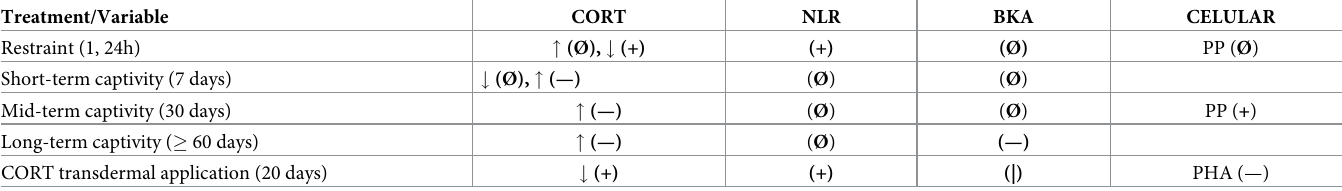
Table 1. Stress and corticosterone transdermal application-related corticosterone plasma levels and immune modulation of R . ornata toads.